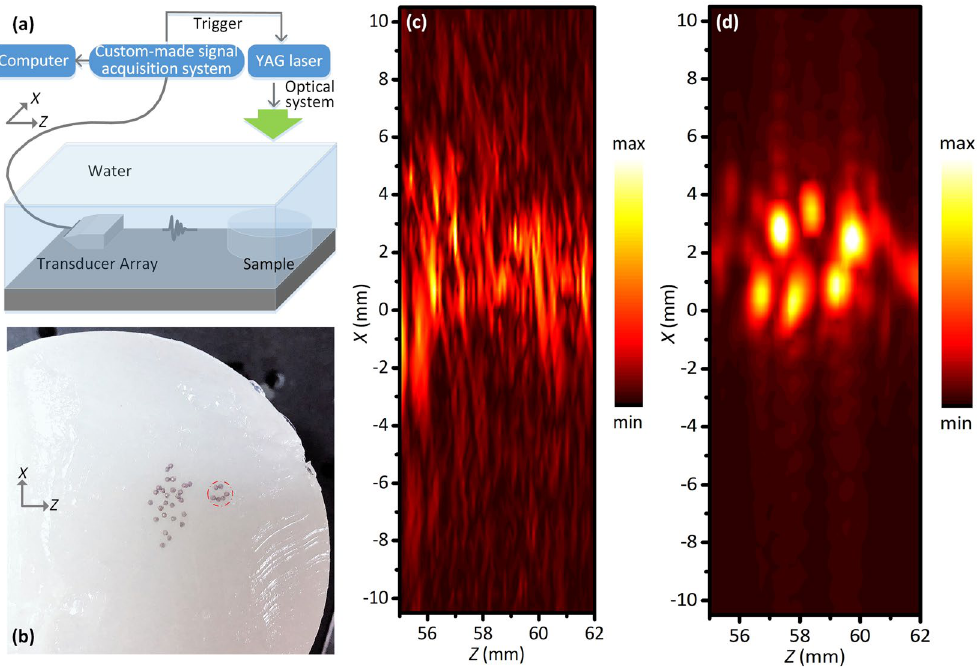
Figure 7. Comparison of experimental results. ( a ) Schematic of experimental set-up. ( b ) Photo of the sample used in the experiment. ( c ) Image reconstructed by the DAS method. ( d ) Image reconstructed by the CFMF